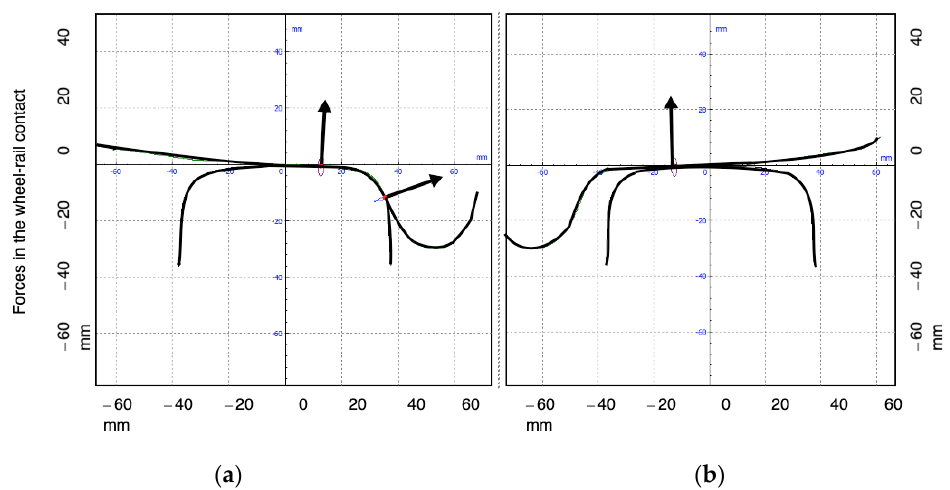
Figure 19. Forces in the wheel – rail contact and their position in the right turn: ( a ) Left wheel; and ( b ) right wheel. ( b ) right wheel.